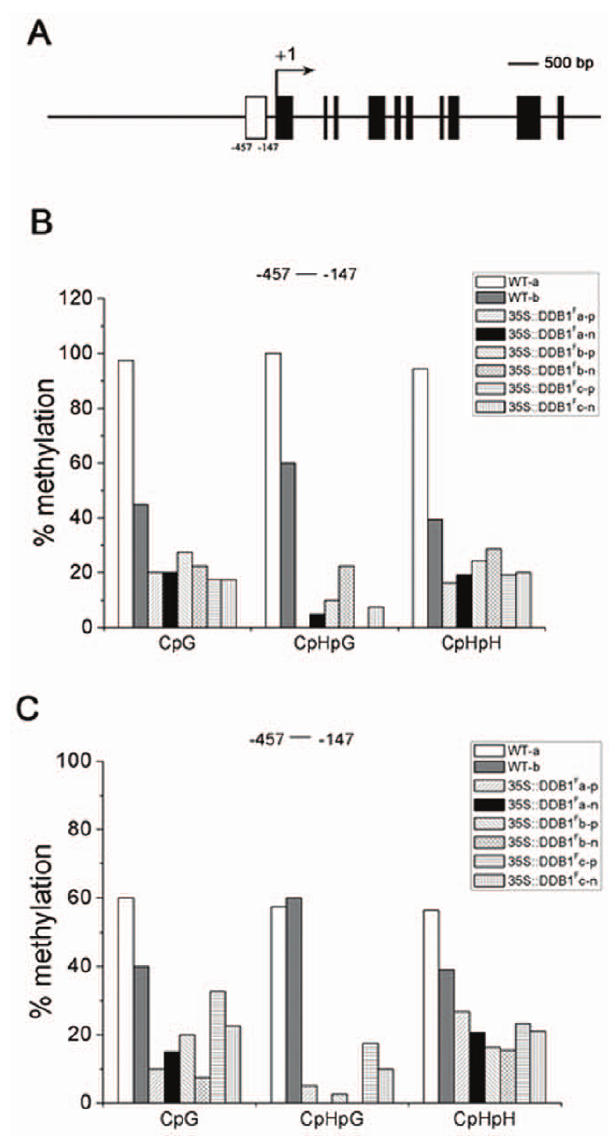
Figure 6. Analysis of SlWEE1 methylation through bisulfite genomic sequencing. (A) A schematic diagram of SlWEE1 gene structure, with + 1 indicating the transcription start site and rectangle representing the methylation region 2 457 to 2 147. (B) and (C) Histograms of the percentage of CpG, CpHpG, and CpHpH methylation at region 2 457 to 2 147 of the SlWEE1 gene from WT Ailsa Craig ( WT ) and 35S::DDB1 F T 1 (B) and T 2 (C) transgenic lines (a, b, c). p and n represent plants with or without transgene, respectively. H represents A, T or C.